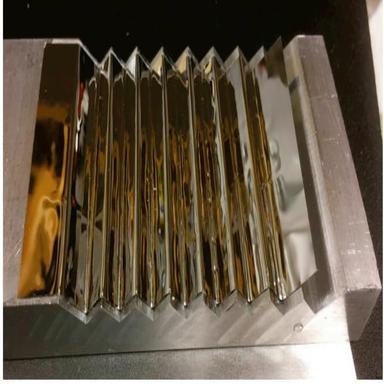
Aluminized Mylar adhered with double-sided tape to a pre-shaped aluminum block with 7-mm pitch orthogonal grooves. With this method, the groove faces are decently smooth, but the added thickness from the layer of tape makes it difficult to conform to the sharp edges of the grooves.